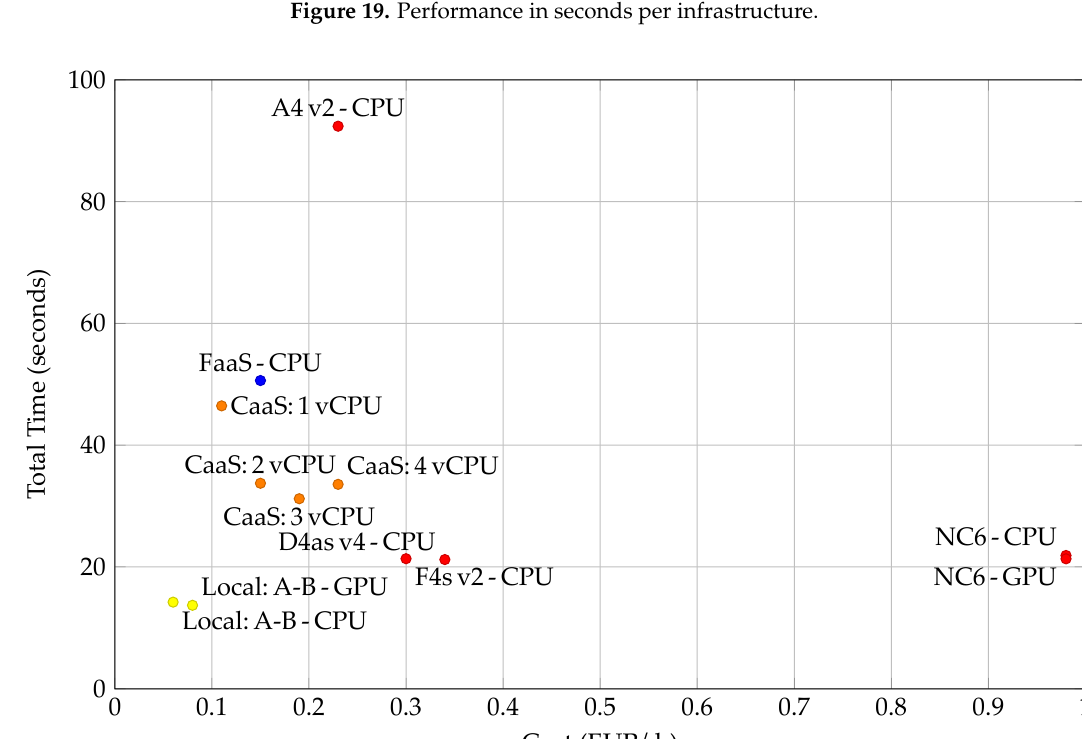
Figure 20. Cost performance per infrastructure. Prices and the computing power are subject to change (April